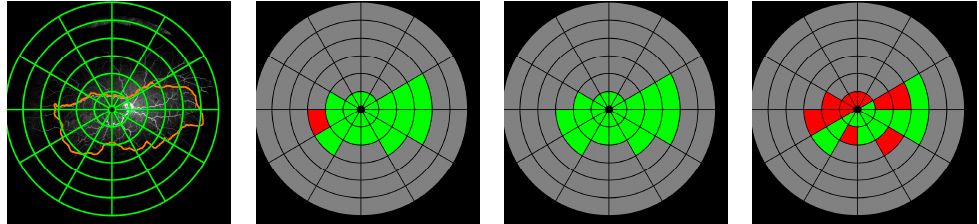
Figure 5. Grid assessment examples. Left to right: FA image, grid annotation from grader 1, automated assessment, grid annotation from grader 2 (Kappa values. Ex. 1: Auto 0.80, Grid2 0.65; Ex. 2: Auto 0.93 Grid2 0.74; Ex.3: Auto 0, Grid2 0.08).